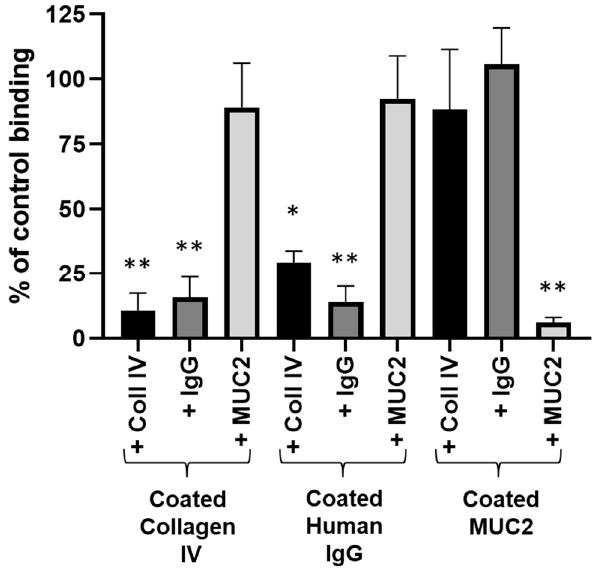
Figure 6. The interaction of GST-RadA 35-252 with collagen IV, human IgG or type II mucin involves two separate domains/mechanisms. GST-RadA 35-252 was pre-incubated with soluble collagen IV, hu- man IgG or type II mucin (MUC2) (400 nM) before being added to wells coated with collagen IV, human IgG or type II mucin (MUC2) (protein-coated at 4 pmol per wells (40 nM)) as explained in Materials and Methods. Results are expressed as means ± S.D. with *: p < 0.01, **: p < 0.001 ( n =